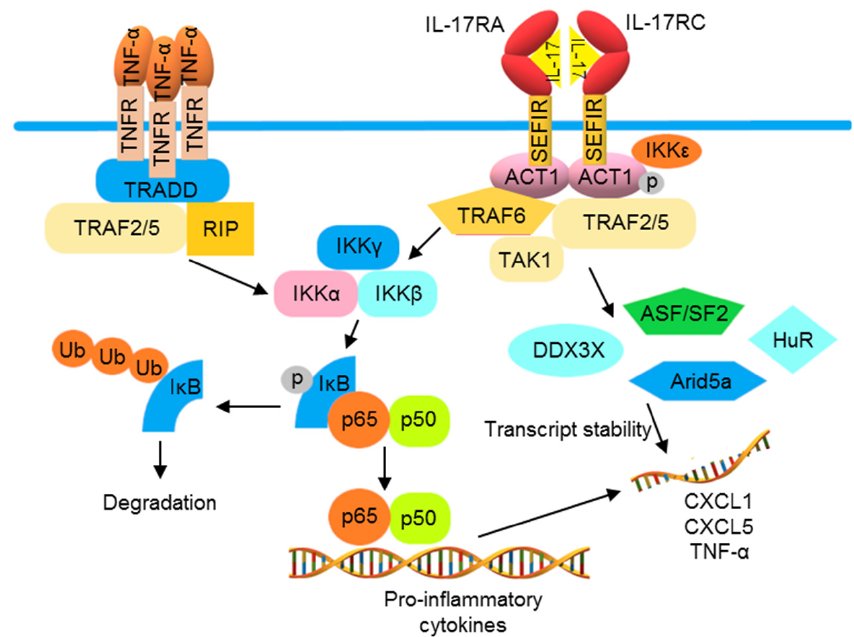
Figure 3. TNF- α and IL-17 cooperate to promote the production of pro-inflammatory cytokines. The activation of TNFR induces the production of pro-inflammatory cytokines by recruiting TRADD, TTRAF2 and 5, and RIP1 to the receptor, thus activating the IKK complex and NF- κ B. IL-17 receptor (IL-17R) signaling can also induce NF- κ B via ACT1 and TRAF6. Furthermore, IL-17R initiates mRNA stabilization signaling through the IKK ε -mediated phosphorylation of ACT1, which binds to TRAF2 and 5 to activate mRNA binding proteins to increase mRNA instability. The combination of TNFR and IL-17R activations often results in a synergistic inflammation that can be partially explained by increased mRNA expression and stabilization.